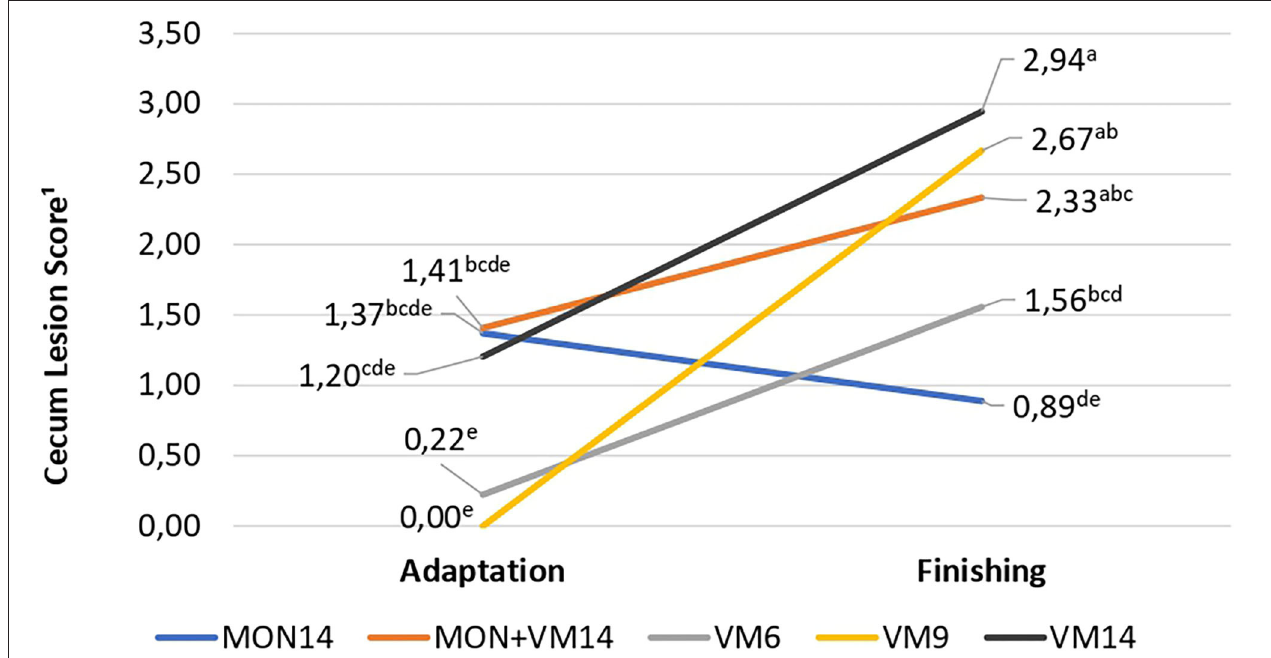
FIGURE 1 | Interaction of treatments with periods (adaptation and finishing) for cecum lesions score of Nellore cattle consuming high-concentrate diets containing sodium monensin (MON), virginiamycin (VM), or both during adaptation and finishing period. MON14, 27mg of MON/kg of dry matter (DM) and adaption for 14 days; MON + VM14, 27mg of MON/kg of DM and 25mg of VM/kg of DM and adaption for 14 days; VM14, 25mg of VM/kg of DM and adaption for 14 days; VM9, 25mg of VM/kg of DM and adaption for 9 days; and VM6, 25mg of VM/kg of DM and adaption for 6 days. Means without a common superscript letter differ ( P < 0.05); pooled SEM (0.59 and